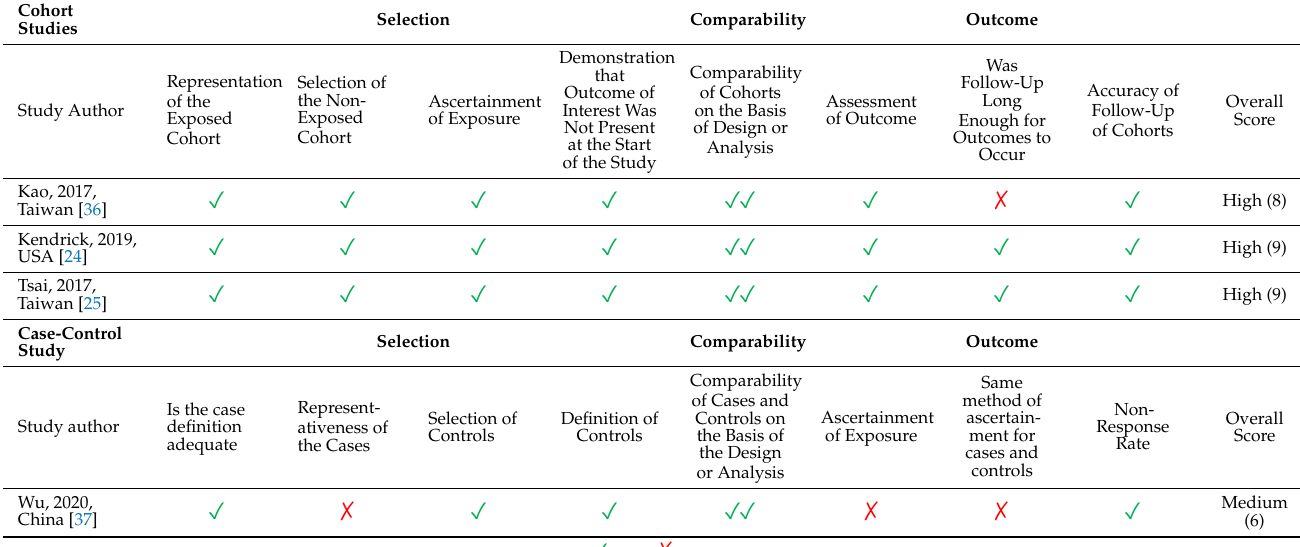
Table 2. Quality assessment of included studies.